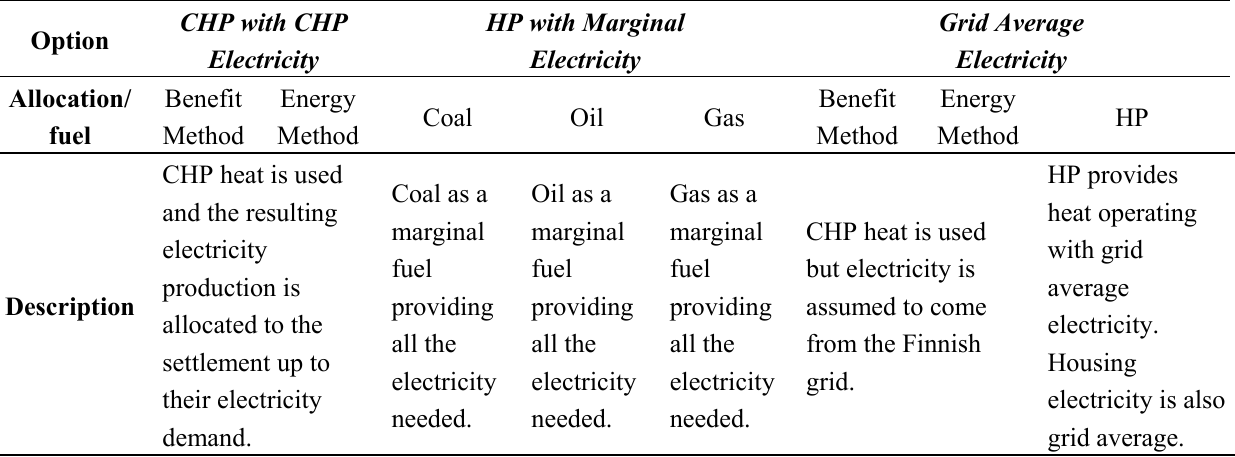
Table 2. Compared energy